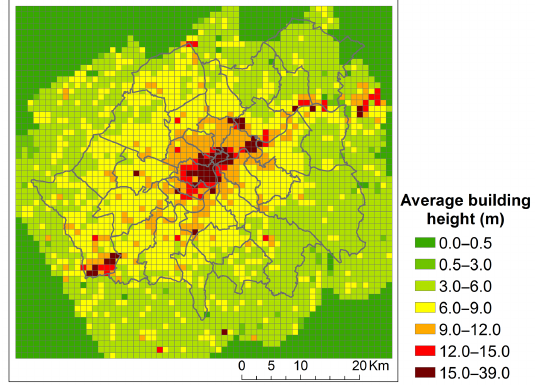
Figure 3. Spatial variation of the average building height (1km × 1km grid cells) for Greater